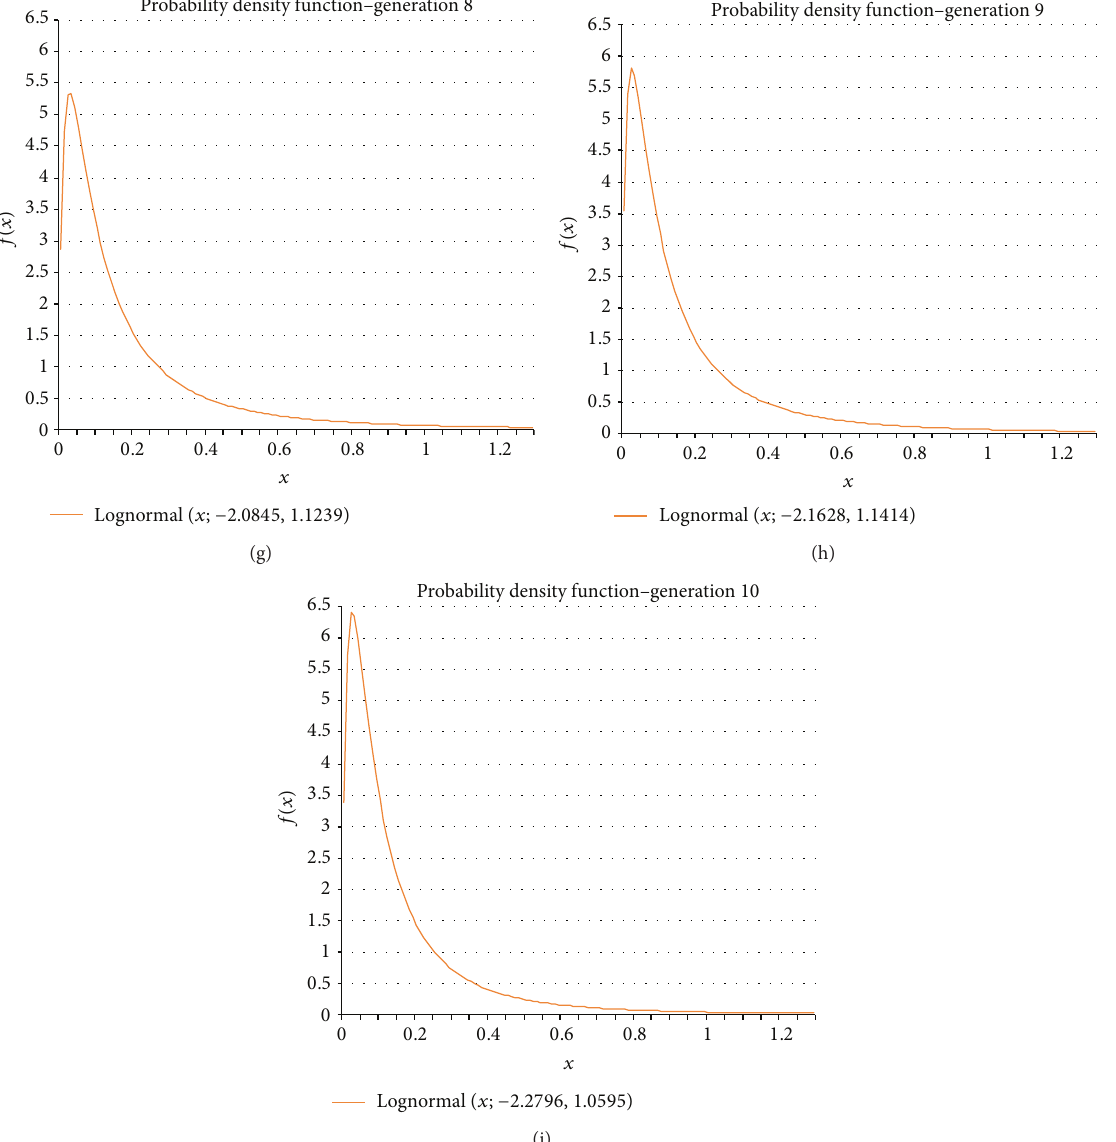
Figure 5: Probability density functions for the obtained errors at each generation of the evolution